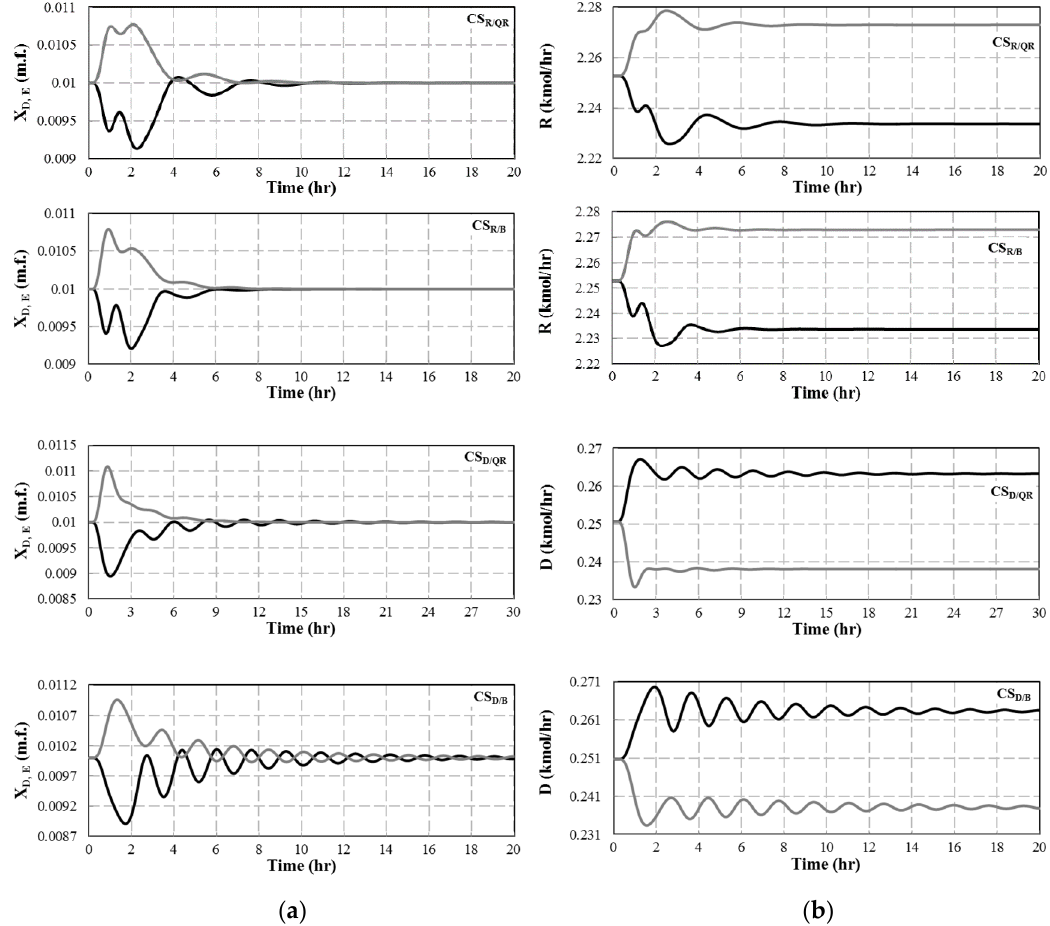
Figure 6. Dynamic responses of the top control loop of the MEPB Kaibel distillation column controlled, respectively, under the CS R / QR , CS R / B , CS D / QR , and CS D / B structures after facing a ± 5% variation in M feed composition ( + 5%: black curves and − 5%: grey curves): ( a ) controlled variables; ( b ) manipulated variables.